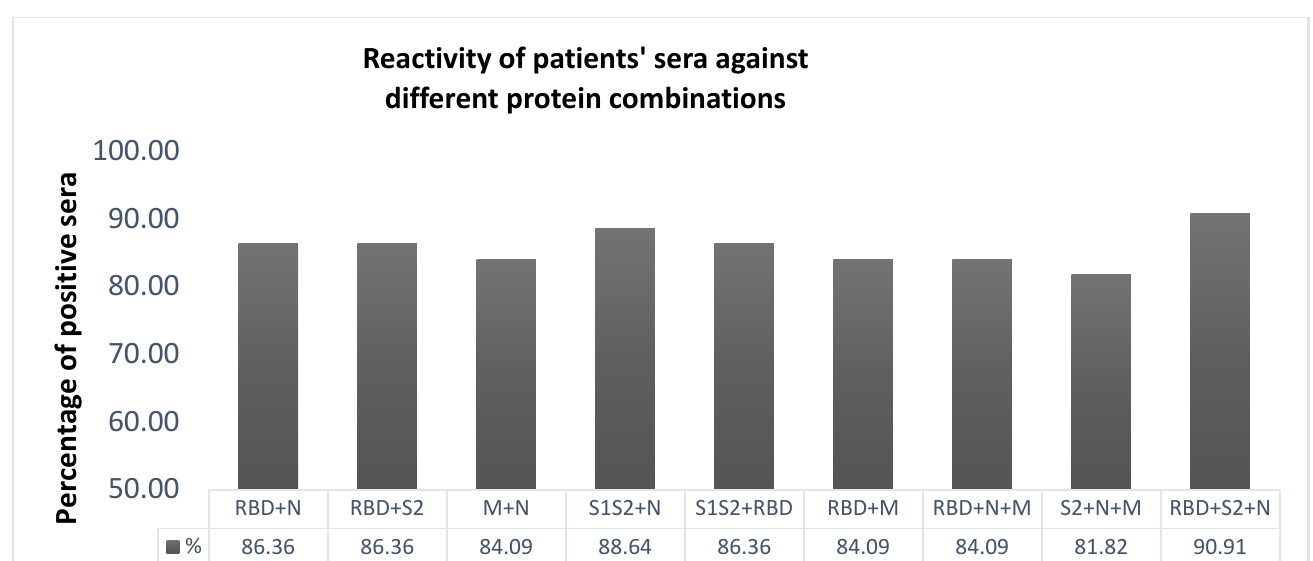
Figure 3. Prevalence of antibodies against different combinations of protein antigens in patients’ sera. Mixtures of all potential combinations of protein antigens were evaluated in terms of their antigenicity among patients’ sera (at a dilution of 1:100). The concentrations of antigens in every mixture were the same as when used separately (RBD 2.5μg/mL, S1 1μg/mL, S1S2 1μg/mL, S2 1μg/mL, M 2μg/mL, N 1.5μg/mL). The cut-off value for each antigen was determined using the mean optical density plus 2 SDs of controls.